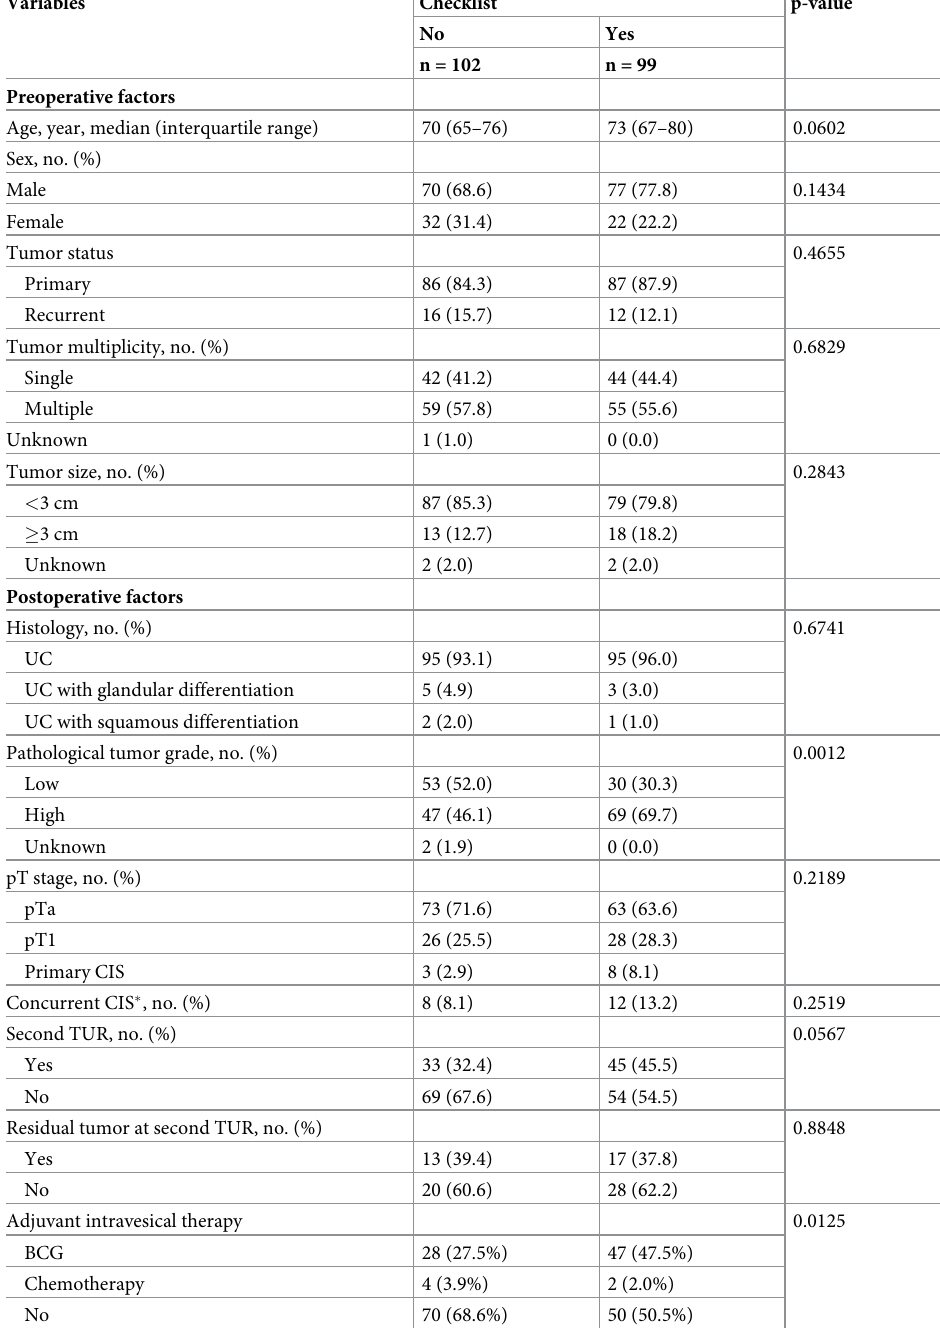
Table 1. Distribution of patient